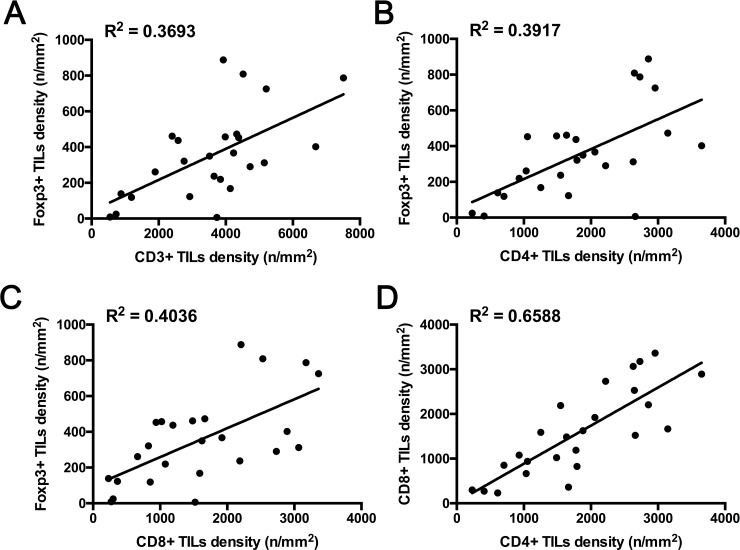
Correlation between densities of different tumor-infiltrating lymphocyte subtypes.Linear regression models reveal associations between Foxp3+ and CD3+ (A: P = 0.001), Foxp3+ and CD4+ (B: P < 0.001), Fox3+ and CD8+ (C: P < 0.001), and CD4+ and CD8+ (D: P < 0.001) TIL densities.